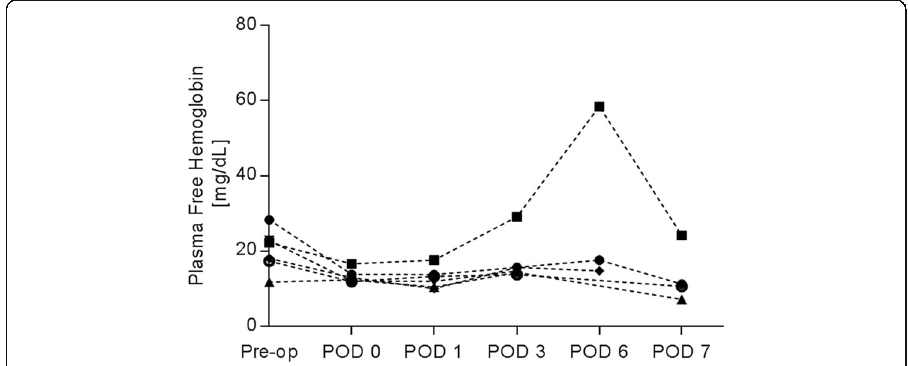
Fig. 3 Plasma-free hemoglobin generated during the adult low-flow ECCO 2 R ModELAS in vivo study. Legend: ● animal 1; ■ animal 2; ▲ animal 3; ▼ animal trial 4; ♦ animal 5; ○ animal